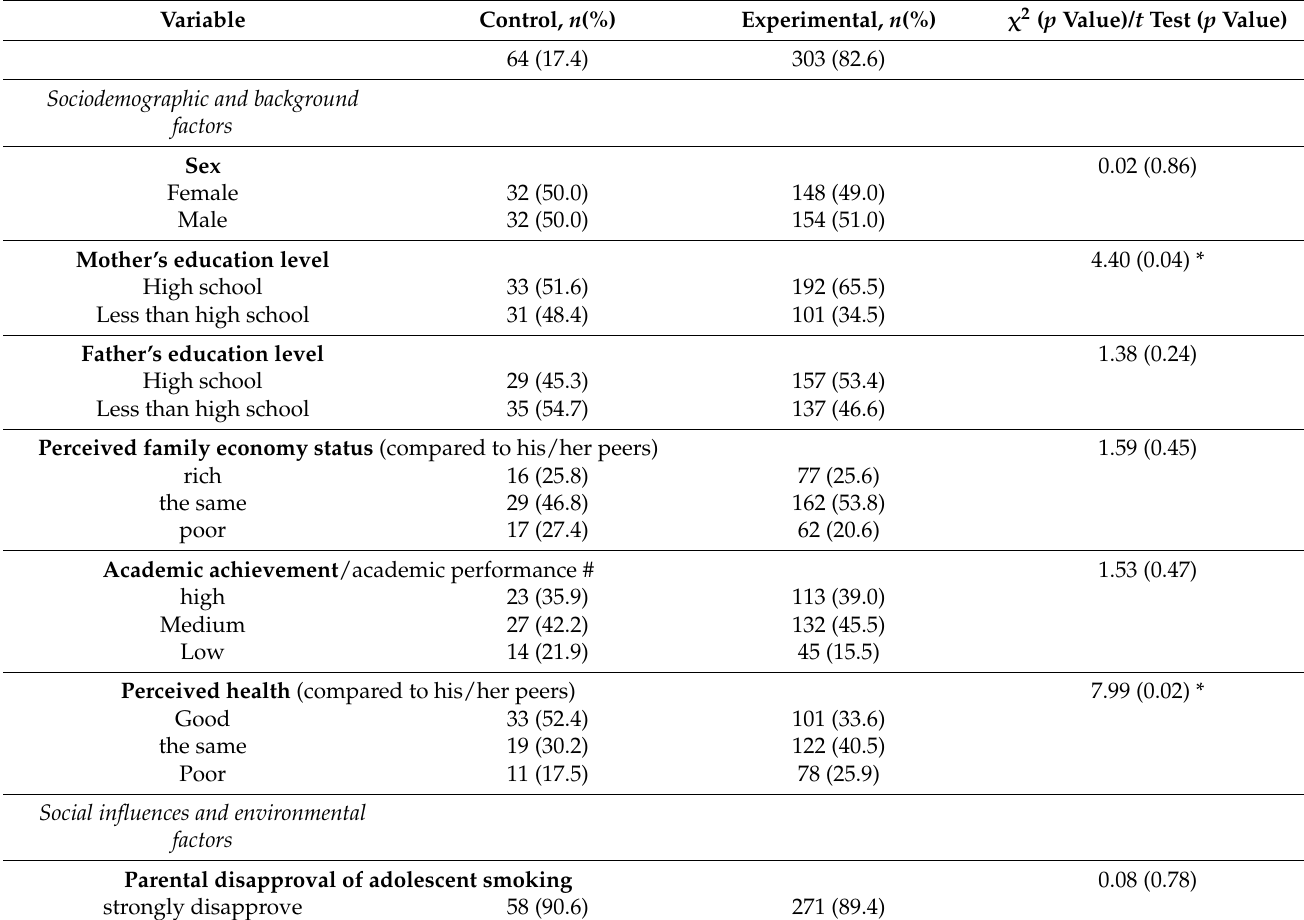
Table 2. Differences of demographic characteristics of participants between the experimental and control groups ( n =